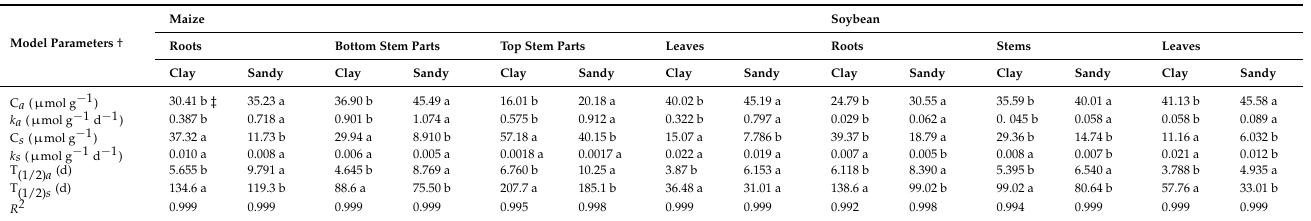
Table 3. First order decay model parameters and coefficients of determination ( R 2 ) for C mineraliza- tion in soils amended with different residue